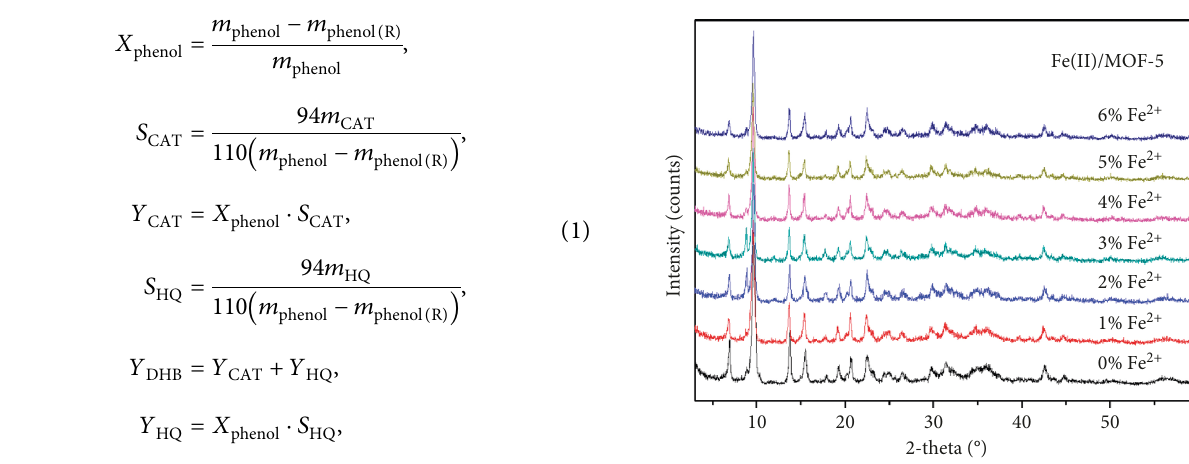
Figure 1: XRD patterns of